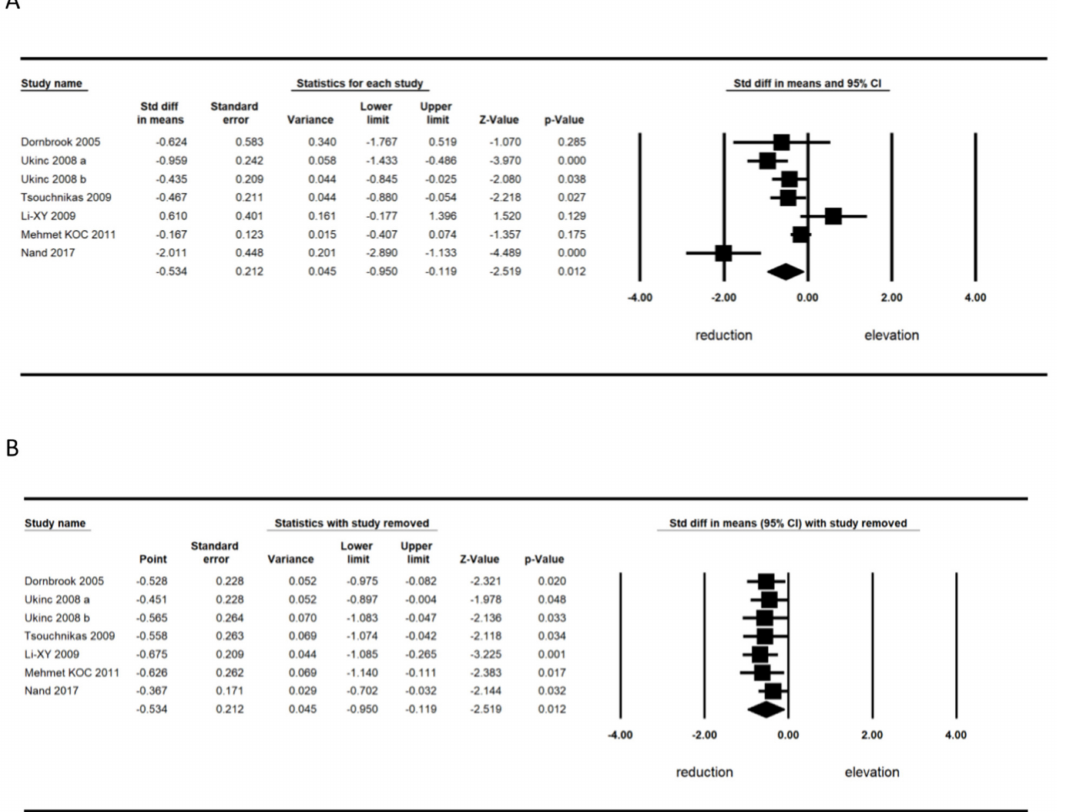
Figure 4. ( A ) Forest plot displaying standardized mean differences and 95% confidence intervals showing the consequence of statin treatment on serum hs_CRP level. ( B ) Leave-one-out sensitivity analyses